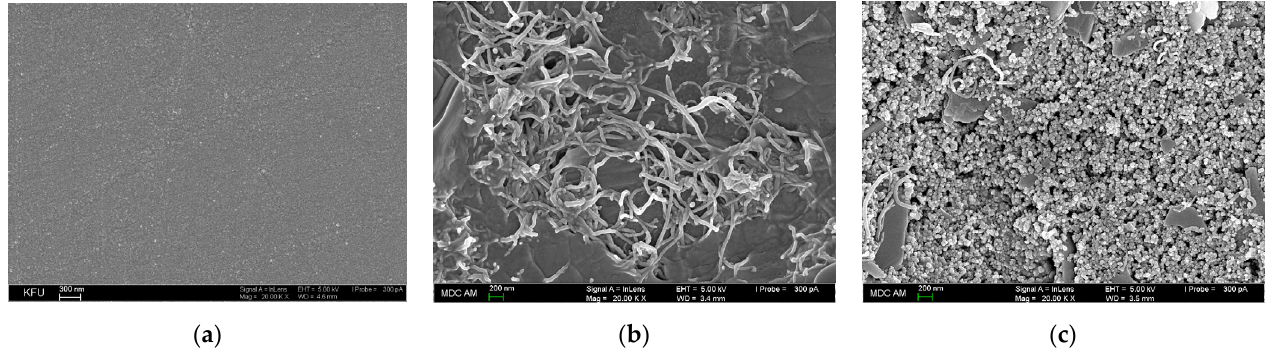
Figure 4. Surface morphology of the electrodes based on the scanning electron microscopy data: ( a ) Bare GCE; ( b ) MWCNTs/GCE; ( c ) Polythymolphthalein/MWCNTs/GCE. ( a ) Bare GCE; ( b ) MWCNTs/GCE; ( c )